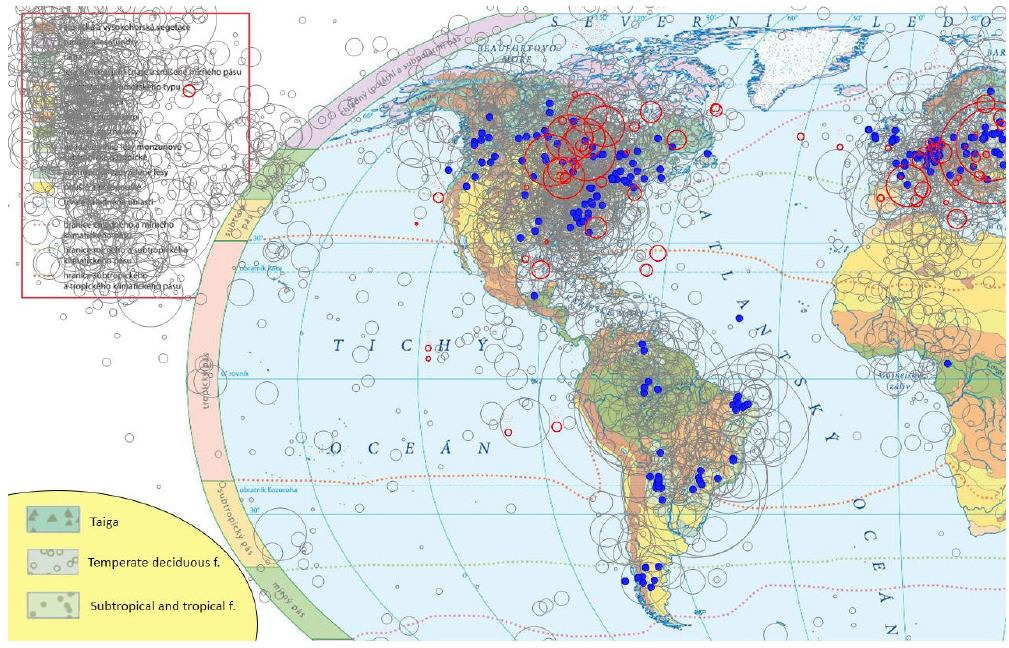
Figure 6. Fixations of students (grey) and their teacher (red), together with answers (blue dots). Similar symbols from the legend are enlarged in the left lower corner.